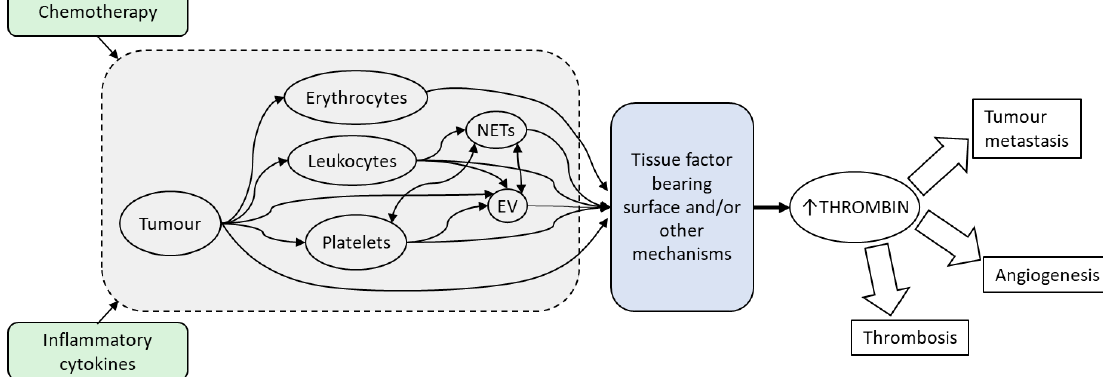
Figure 1. The high occurrence of cancer-associated thrombosis is associated with elevated thrombin generation. Tumour cells increase the potential for thrombin generation both directly, through the expression and release of procoagulant factors, and indirectly, through signals that activate other cell types and components including platelets, leukocytes, erythrocytes, extracellular vesicles (EVs) and neutrophil extracellular traps (NETs). Chemotherapy and the prevailing inflammatory milieu caused by the presence of cancer can stimulate tumour cells and other host cellular components to be procoagulant. Many of these factors potentiate thrombin generation through the expression of tissue factor bearing surfaces that mediates the assembly of coagulation factors essential for the formation of thrombin in vivo. Elevated thrombin production not only increases the risk of thrombosis, but also promotes tumour growth and metastasis and as a consequence, thrombin and its contributors present opportunities for treatment of cancer-associated thrombosis and the underlying cancer.